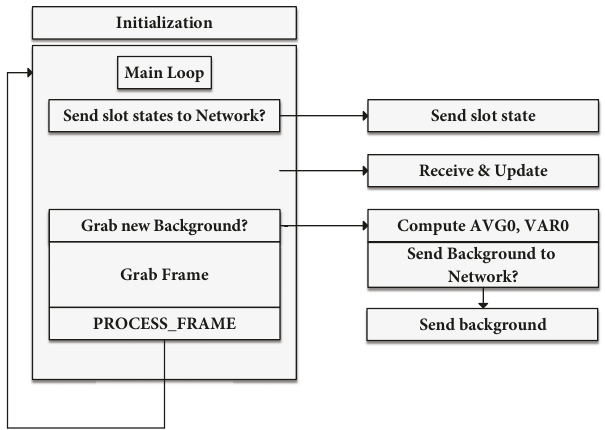
Figure 3: Parking lot occupancy flowchart in analysis software (this figure has been modified after [3] (Magrini et al.,